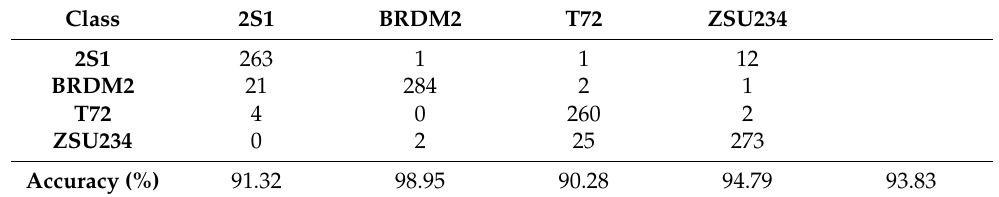
Table 11. Confusion matrix of the amplitude–real–imaginary CNN based on sparse images un- der